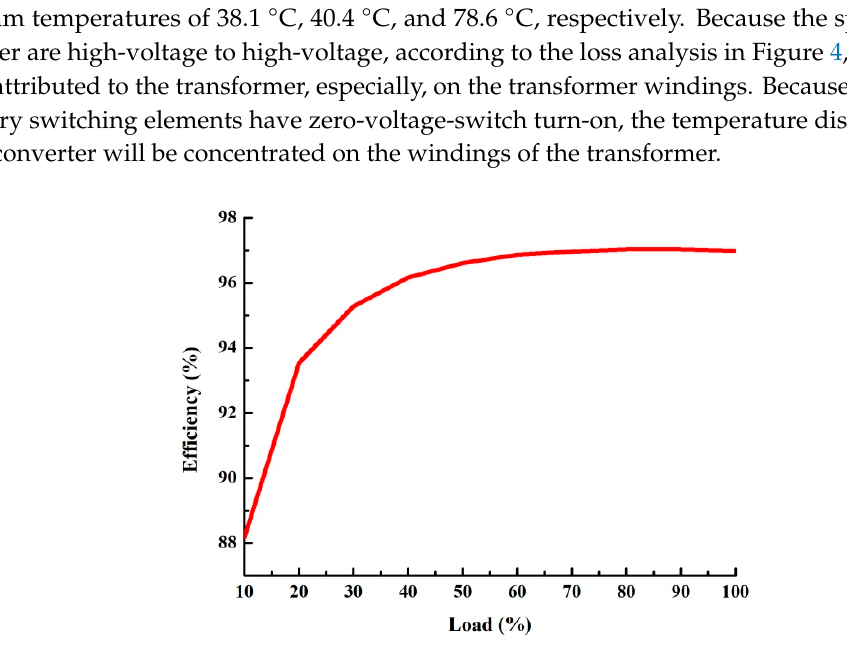
Figure 17. Measured power efficiency.